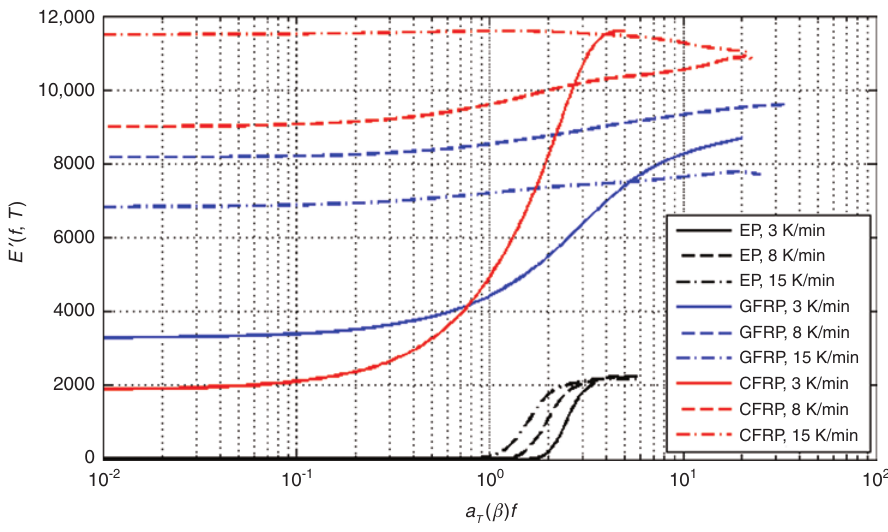
Figure 5: Master curves of the storage modulus for various materials and heating rates.